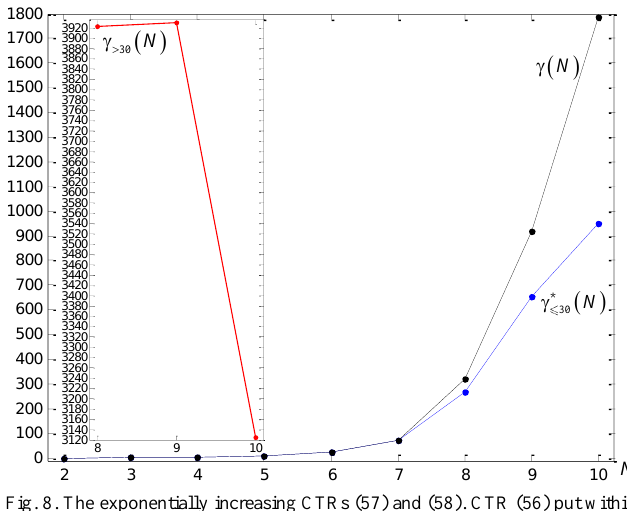
Fig. 8. The exponentially increasing CTRs (57) and (58). CTR (56) put within the same axes is “broken” because of the abrupt intensification of